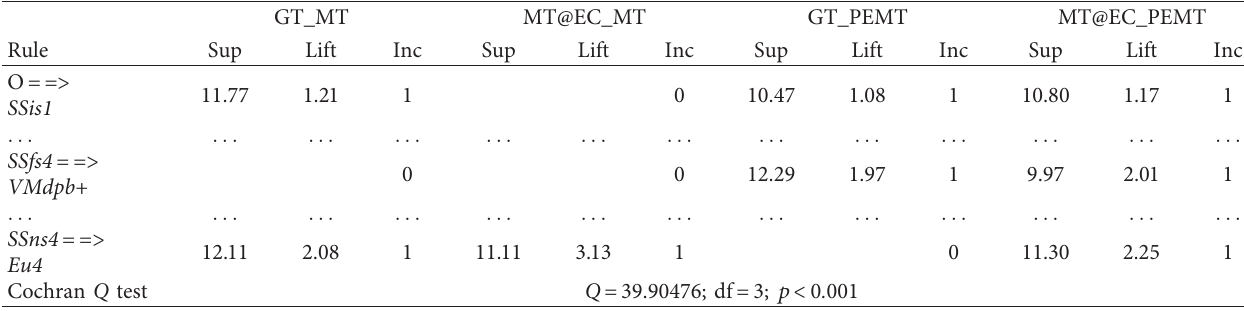
Table 3: Cochran Q test for incidence of extracted rules in examined translations.